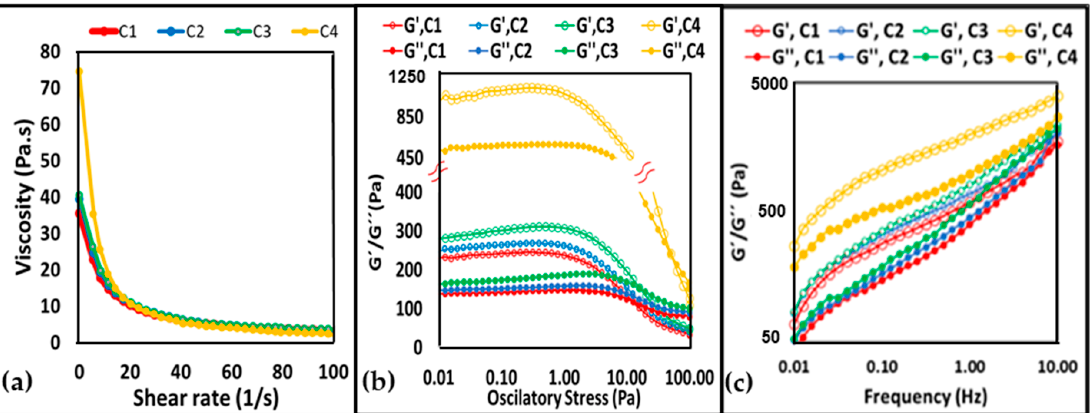
Figure 3. Flow curves plotted as apparent viscosity versus shear rate ( a ); stress sweeps ( b ); and frequency ( c ) tests of C1, C2, C3, and C4 at 25 °C. C1, C2, and C3 contained fats E1 (35% CA and 65% CO), E2 (30% CA and 70% CO), and E3 (25% CA and 75% CO), respectively, and control (C4) contained palm